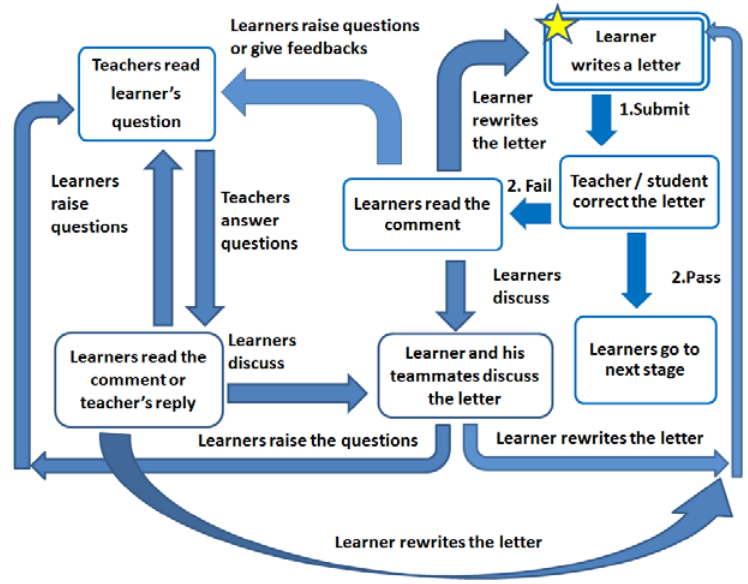
Figure 3 . The flow of business letter